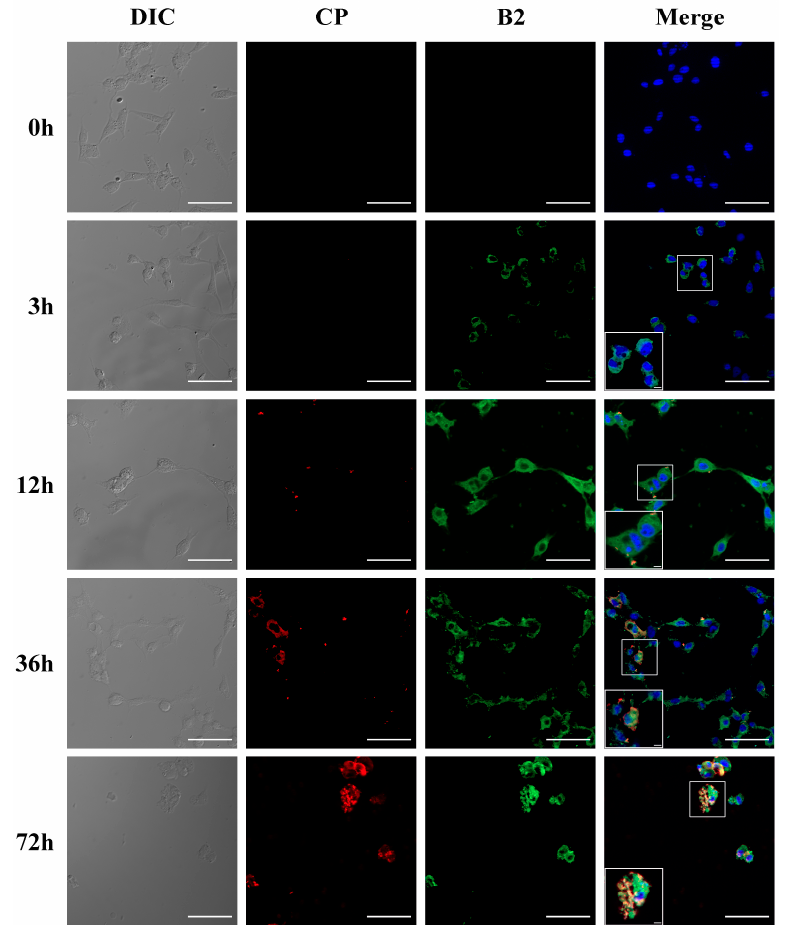
Figure 5. Indirect immunofluorescence analysis of Cp and B2 protein proliferation at different time points after NNV infection with SSN-1 Cells. Scale bars = 50 μ m.